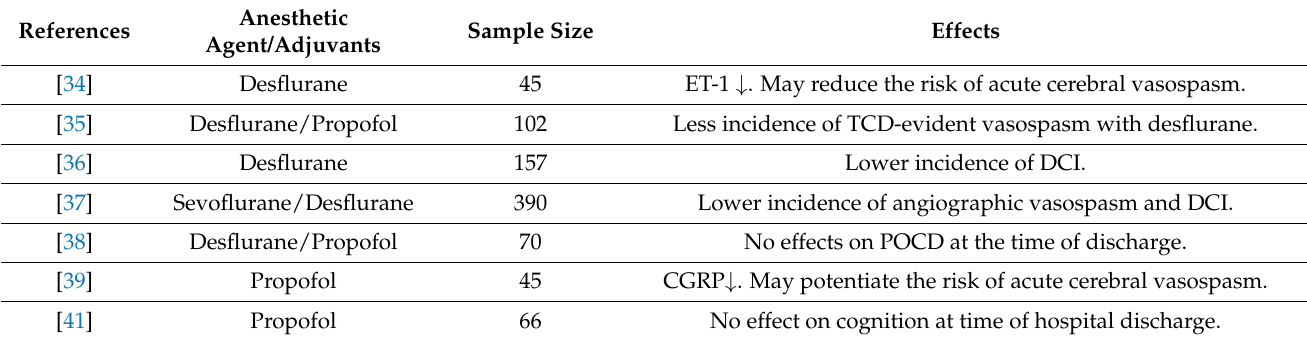
Table 4. Anesthetics and adjuvants in delayed cerebral ischemia (DCI) after SAH in